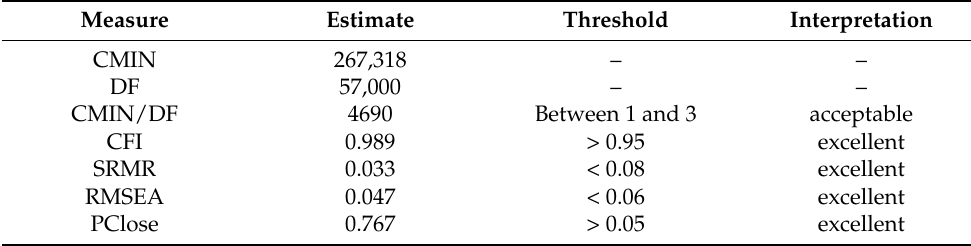
Table 7. Adjustment of the General